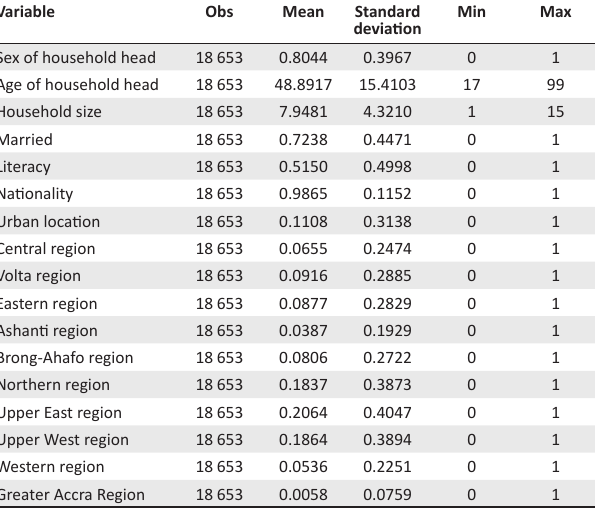
TABLE 2: Sociodemographic characteristics of